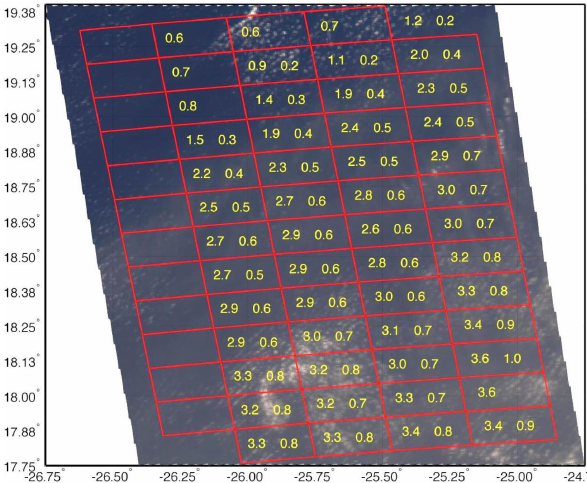
Figure 7. Zoom of the north edge of a dust cloud over the North At- lantic (off the coast of Morocco, 6 June 2012, MODIS 15:15UTC). Overlapped in red are the OMI pixels’ geometrical coordinates (rows 43–47, from left to right) with OMI AAI (left) and OMI AOD388